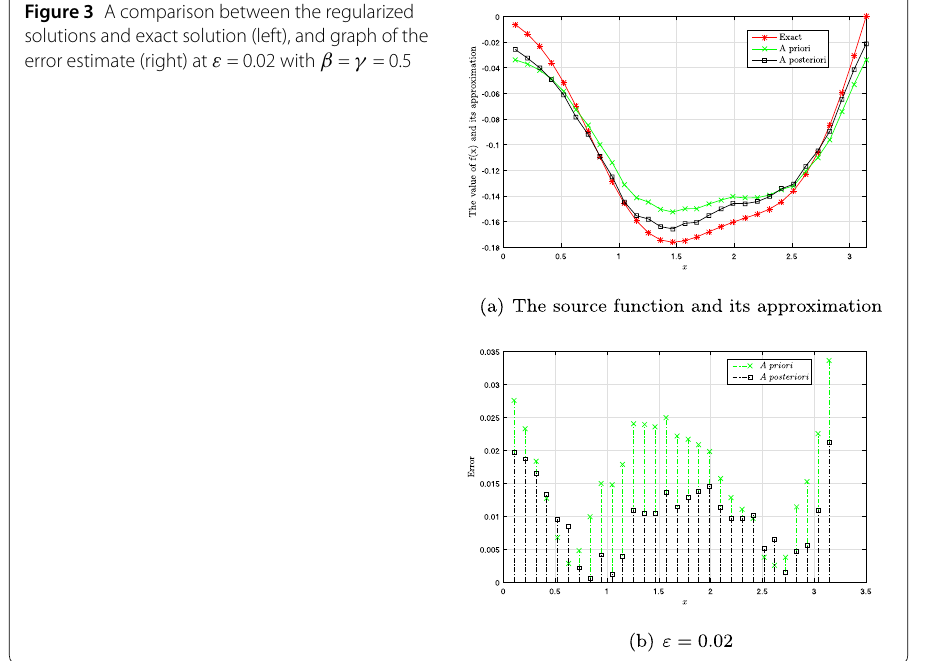
Figure 3 A comparison between the regularized solutions and exact solution (left), and graph of the error estimate (right) at ε = 0.02 with β = γ =